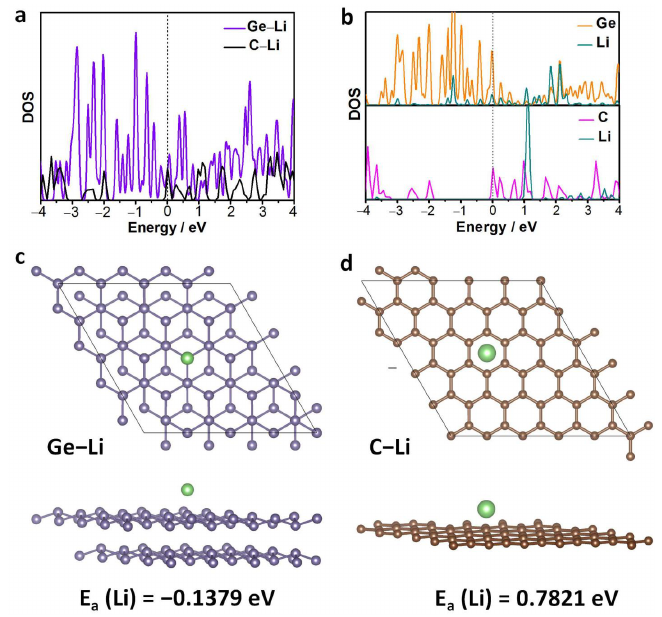
Figure 1. DFT analysis: ( a ) DOS of the Ge–lithium and carbon–lithium alloy; ( b ) DOS of the Ge, carbon, and lithium; ( c , d ) optimized geometry structure of pure Ge and carbon structures. The green atoms represent lithium atoms. The brown atoms represent carbon atoms. The dark blue atoms represent Ge atoms.